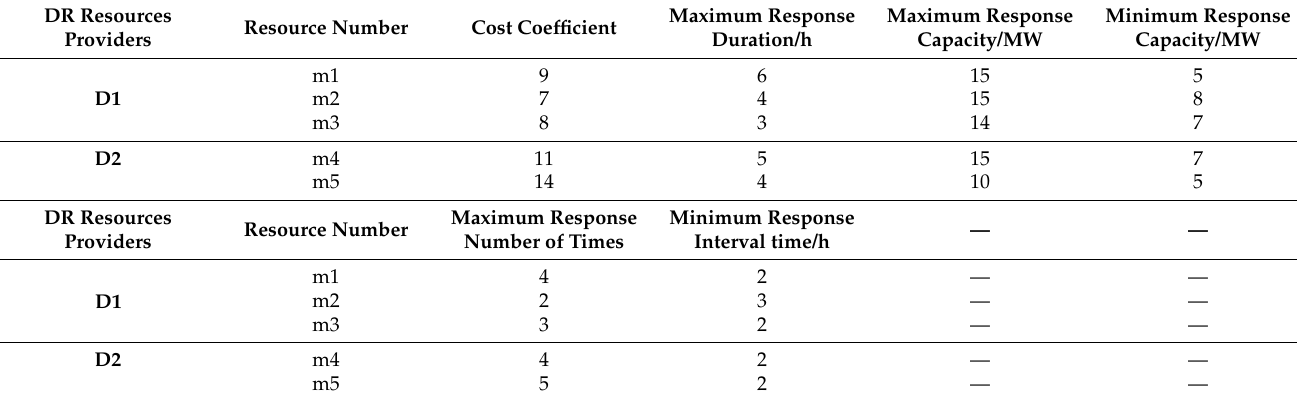
Table A3. IDR characteristic